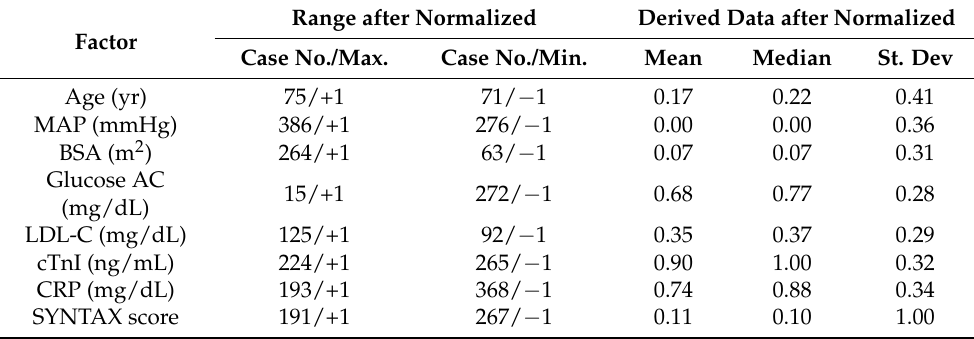
Table 2. The readings of seven factors and the actual (original) SYNTAX scores after the normalization process. The mean value approaches 0.0 if the specific biological index of the patient group follows the normal distribution.